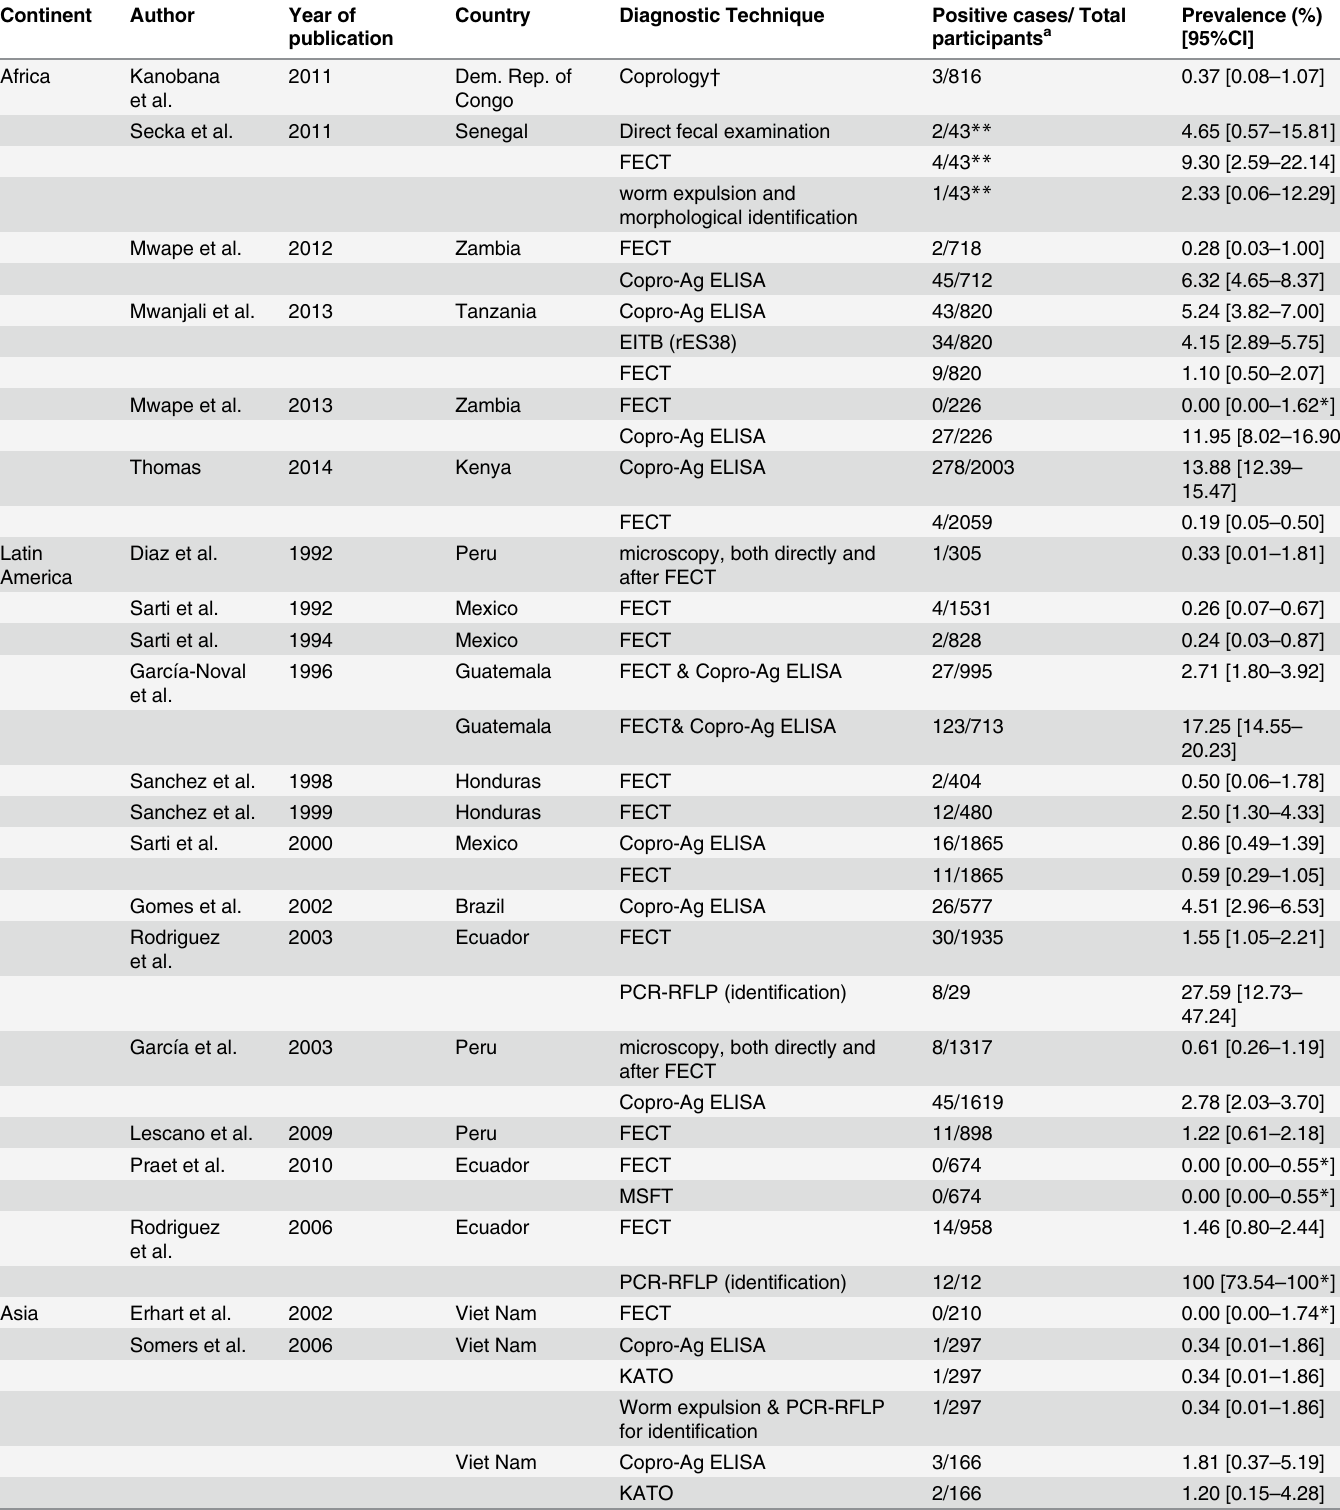
Table 4. Taeniasis reports from Africa, Latin America and